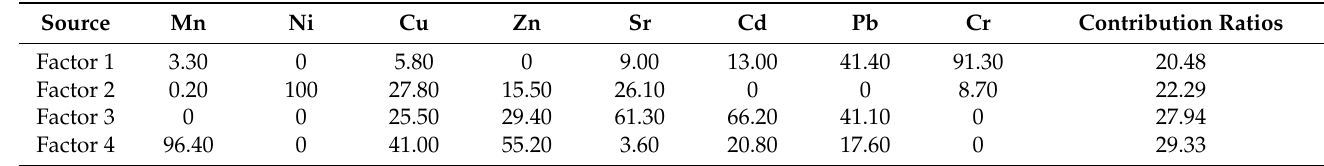
Table 5. Source contribution ratios (%) of heavy